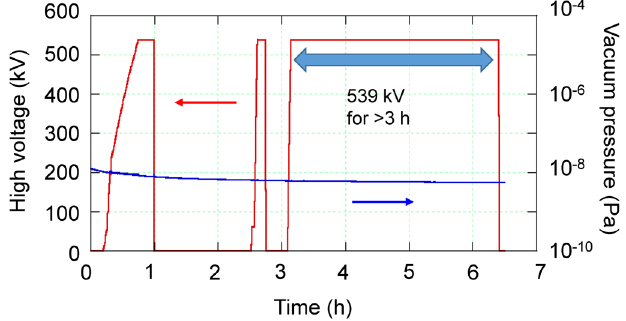
FIG. 6. HV testing for eight- plus two-segment insulator without central stem electrode.